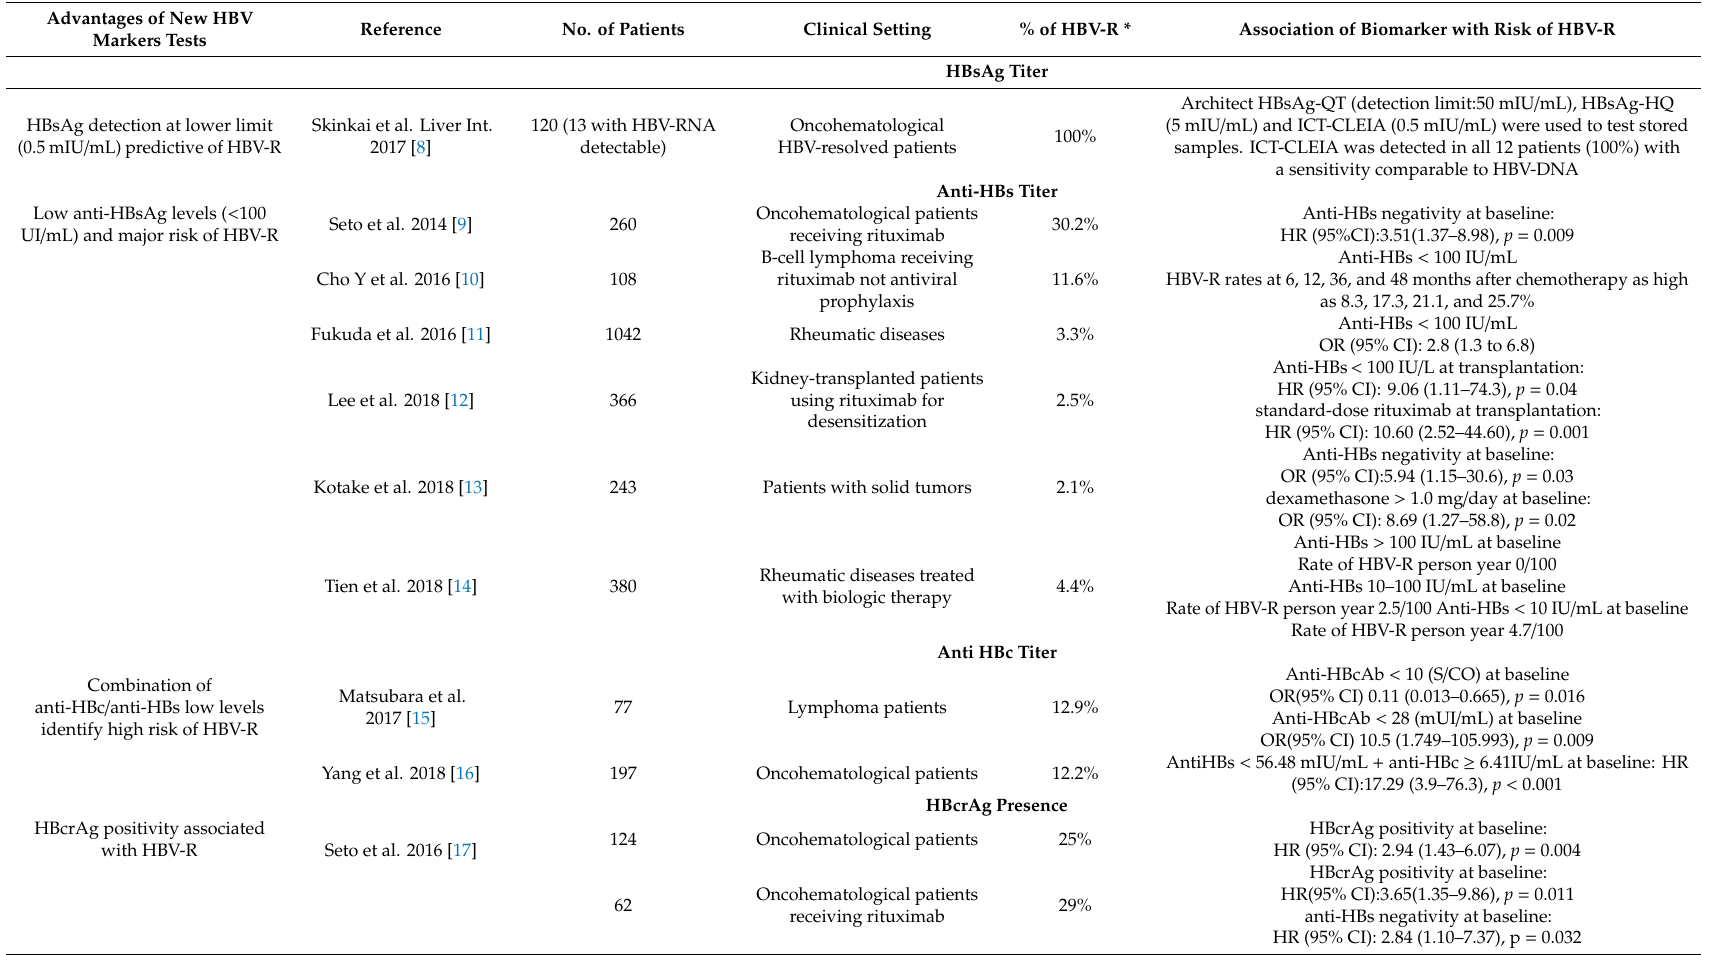
Table 1. Summary of studies led in patients with resolved hepatitis B virus (HBV) infection addressing the role of HBV biomarkers in predicting HBV reactivation. Advantages of New HBV Markers